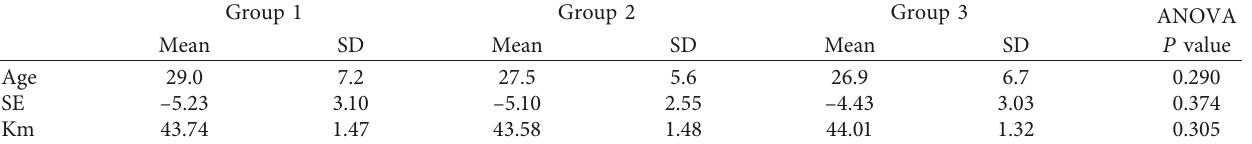
Table 1: Age, refractive spherical equivalent (SE), and mean keratometry (Km) among the studied